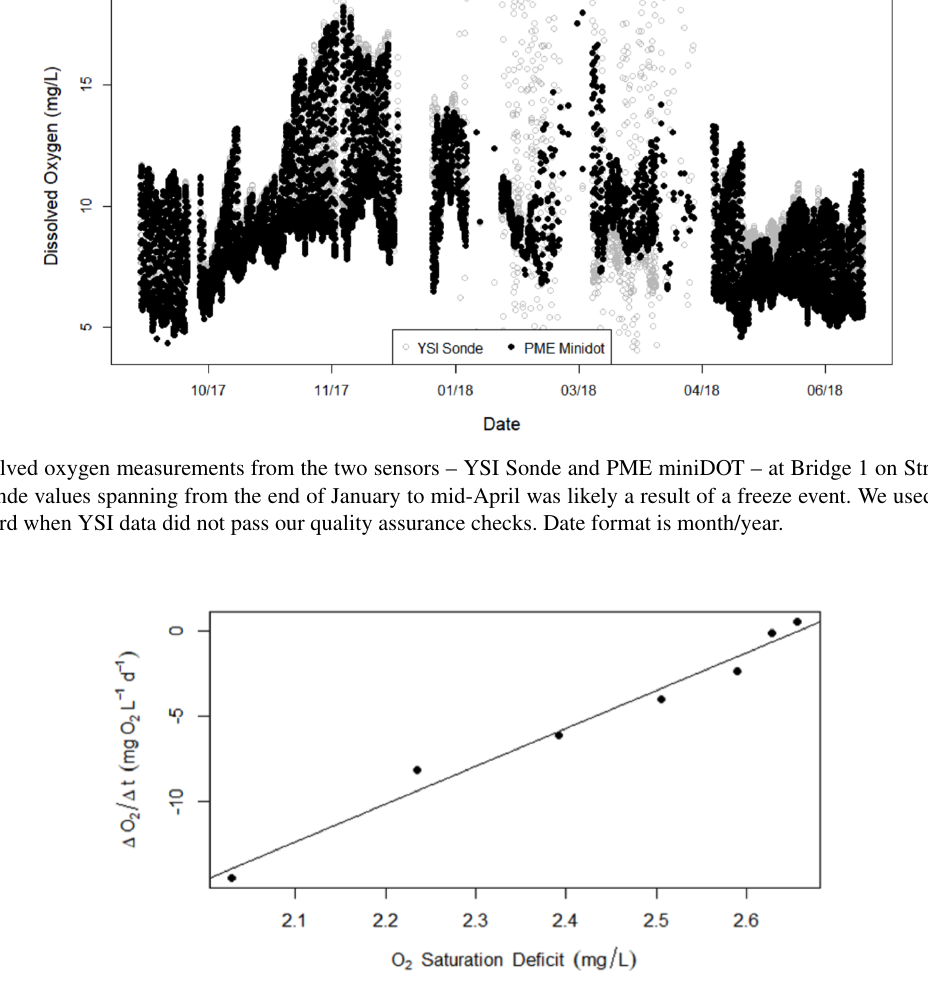
Figure A3. Example of data used to confirm modeled K 600 (d − 1 ) using a regression of the nighttime dissolved oxygen saturation deficit versus changes in saturation (as in Hall and Hotchkiss, 2017). These data are from 4 September 2017, when the estimated value for K 600 was 22d − 1